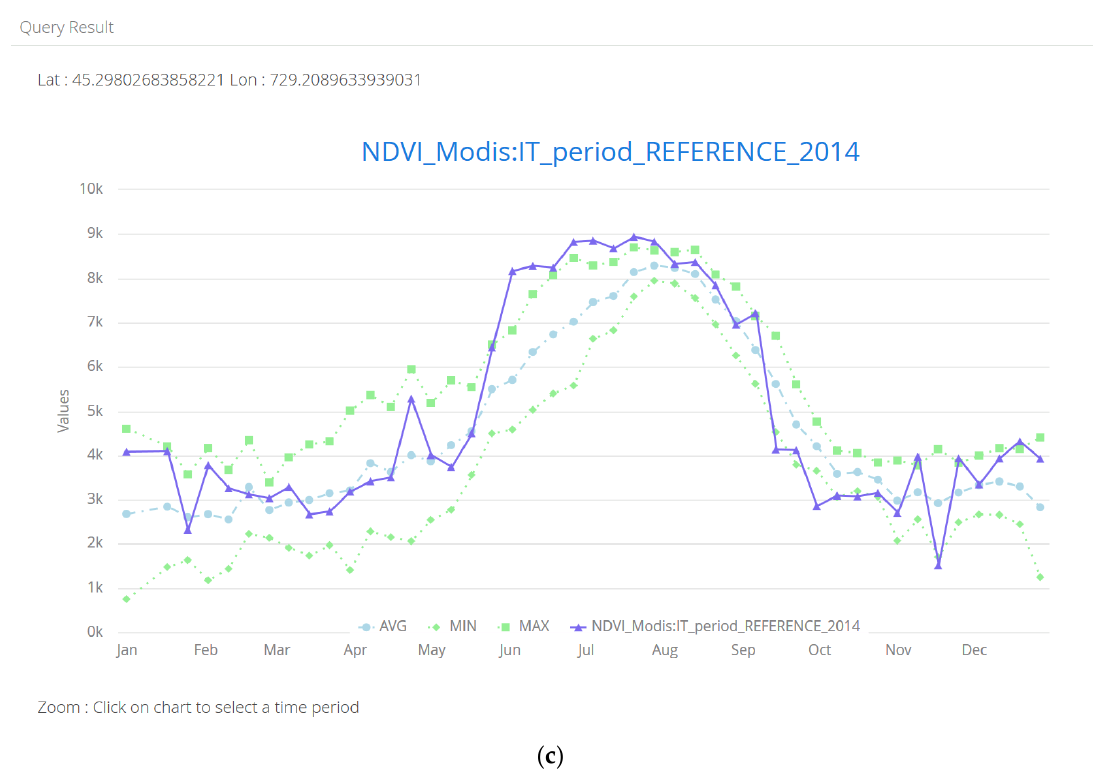
Figure 10. ( a ) S4A geoportal screenshot showing the answer of two spatio-temporal queries over a time series of NDVI for the year 2014, derived by processing MODIS source data, represented in the form of diagram: the diagrams display the temporal variation of NDVI in the selected points (pixels) within rice cultivated fields identified by pins on the geographic area. ( b ) and ( c ) are the diagrams shown in ( a ) in which one can better appreciate the difference of NDVI variation in the two selected points: the blue line is the variation of the NDVI during year 2014 for the a pixel contextually mapped with the average (light blue dotted line), maximum (upper green dotted line) and minimum (lower green dotted line) long term variation of the NDVI for the same pixel (computed over the period 2003–2013). (source: own processing).